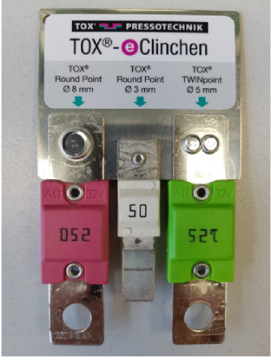
Figure 3. Clinched fuses at a bus bar.